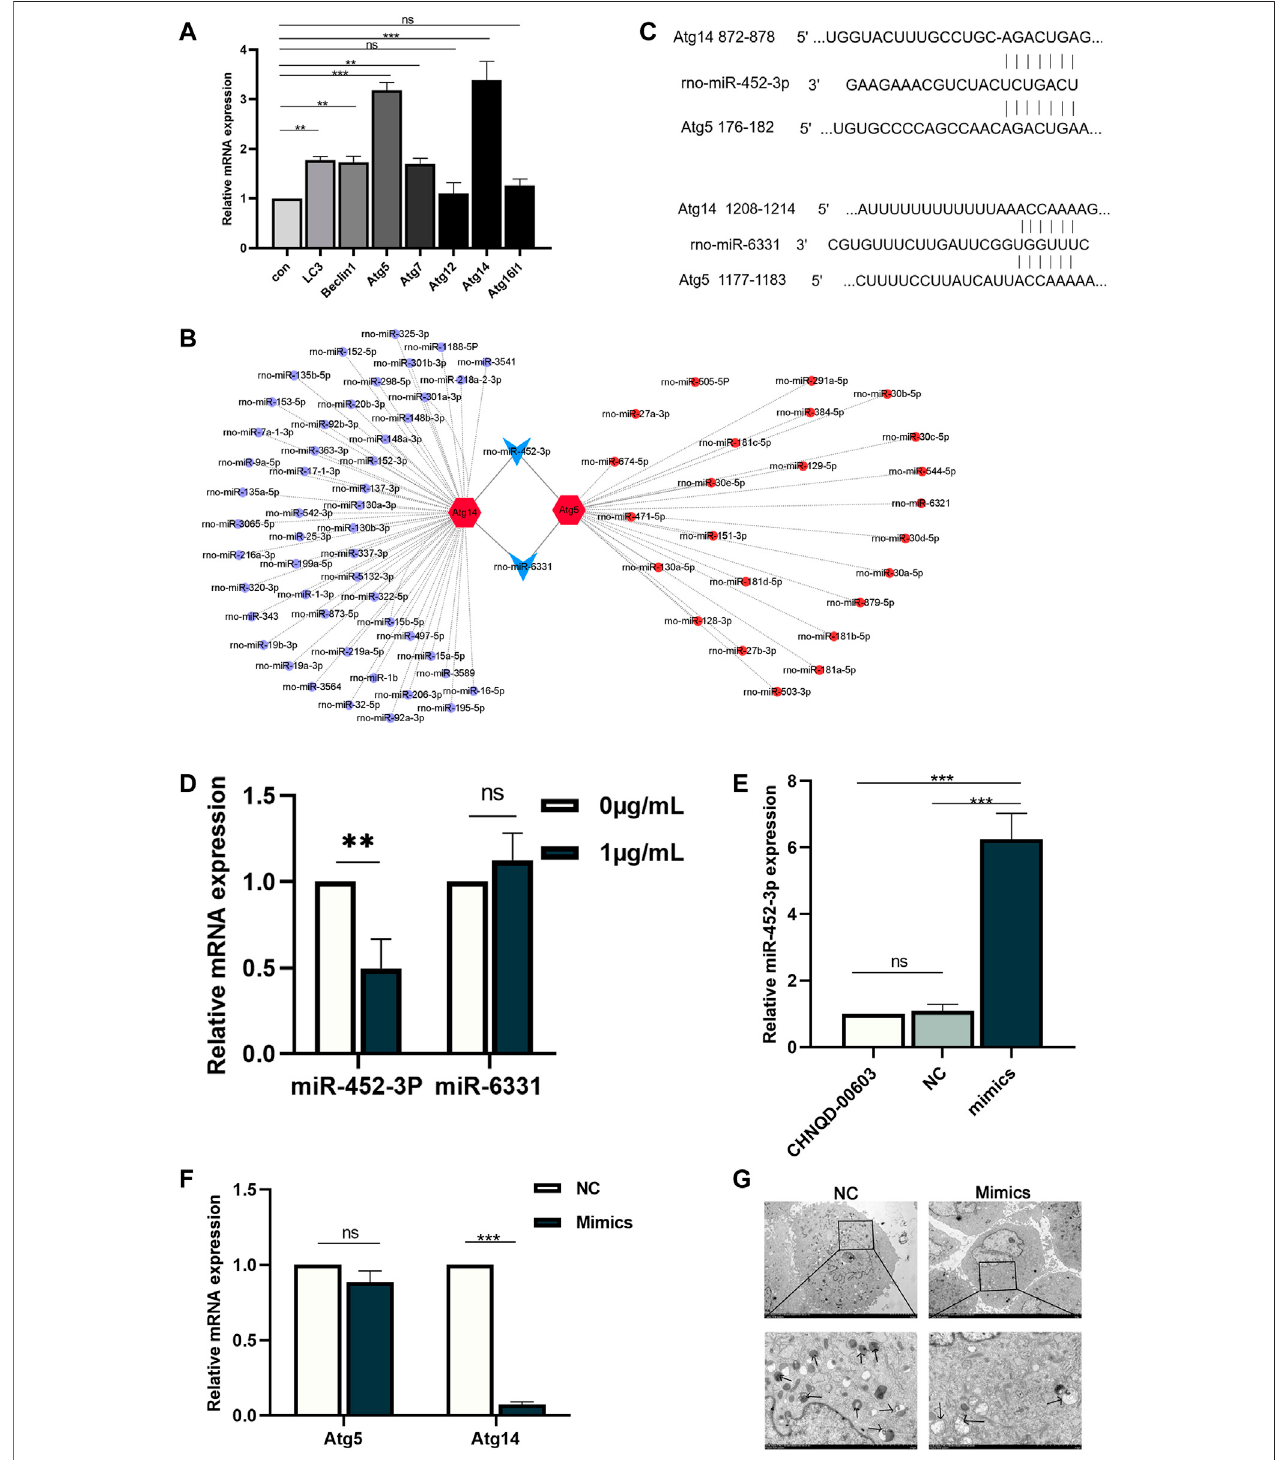
FIGURE 6 | Prediction and validation of potential miRNAs and overexpression of miR-452-3p. (A) Autophagy-related genes were estimated by qRT-PCR. (B) The targeting network was constructed using Cytoscape. (C) The complementary base pairing of miR-452-3p and miR-6331 with Atg5 and Atg14, respectively. (D) qRT- PCR was performed to detect the expression of miR-452-3p and miR-6331 in the osteogenesis of BMSCs treated with CHNQD-00603. Upregulation of miR-452-3p attenuates the level of autophagy. (E) The ef fi ciency of transfecting miR-452-3p mimics was evaluated by qRT-PCR 48 h after transfecting. (F) Autophagy-related genesAtg5andAtg14weredetectedaftertransfectingmiR-452-3pmimicsbyqRT-PCRonday7. (G) Thenumberofautophagosomesonday7wasobservedbyTEM. Quantitative data are presented as the mean ± SD (n (cid:1) 3) (** p < 0.01, *** p < 0.0001).